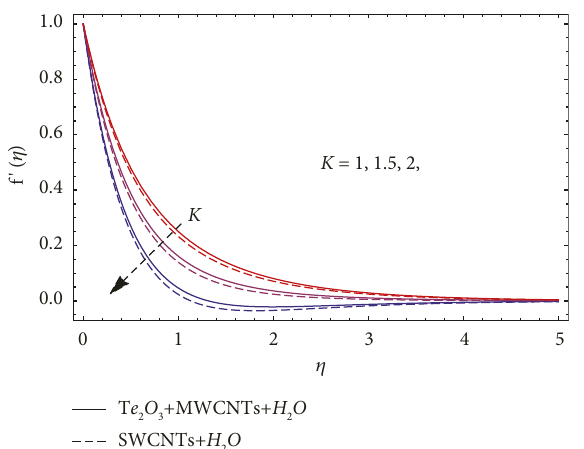
Figure 2: Influence of couple stress parameter on velocity profile in x direction.